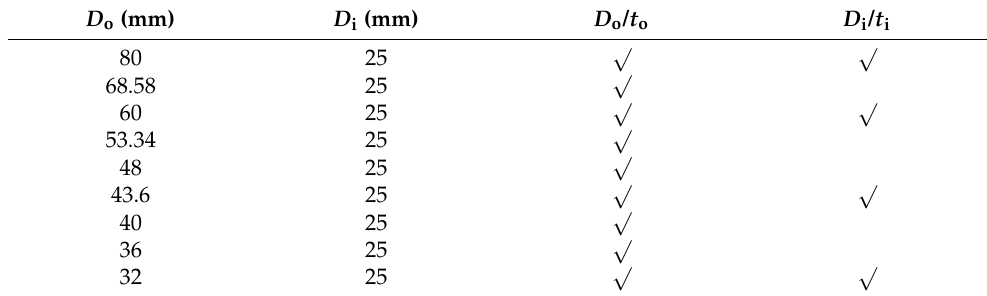
Table 12. Calculated series for the effect of D o / D i.